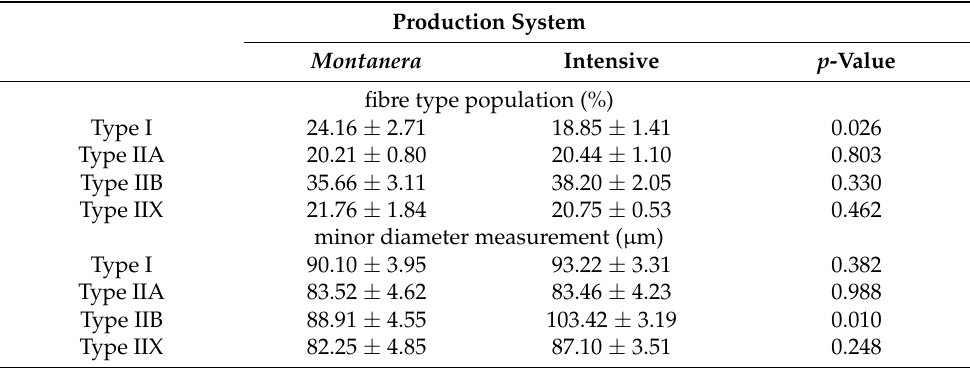
Table 4. Muscle fibre population and size of m. Longissimus thoracis from Iberian × Duroc crossed animals according to production